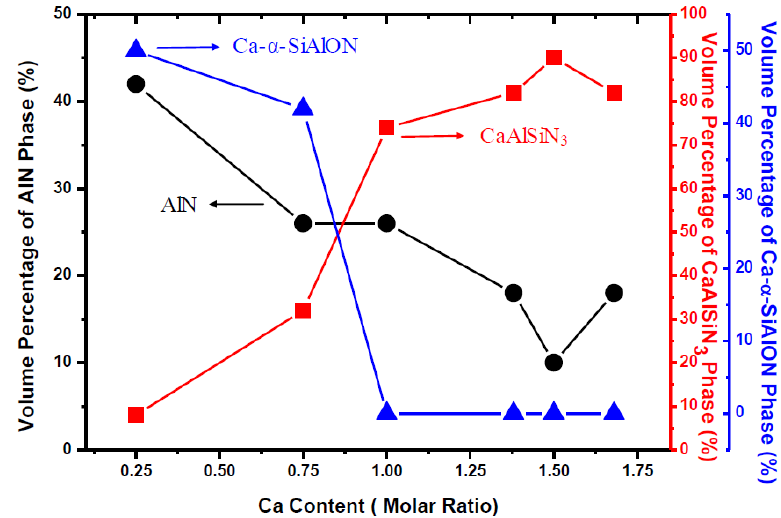
Figure 2. Volume Percentages of AlN, CaAlSiN 3 and Ca-α-SiAlON phases formed during synthesis with various Ca contents.